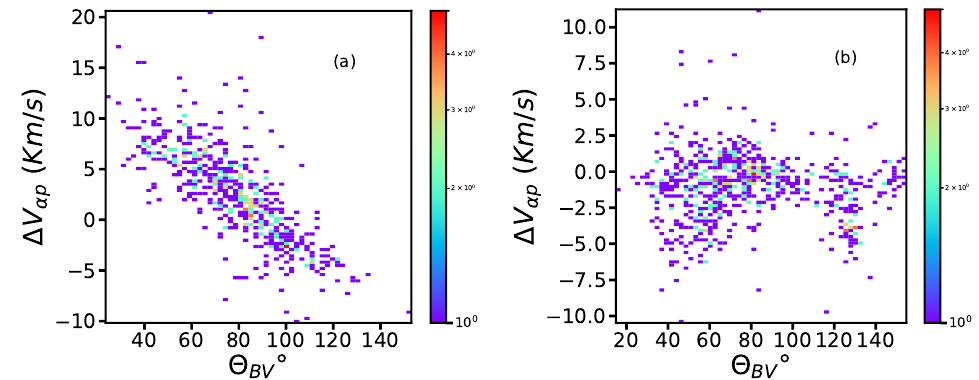
Figure 5. 2D histogram plot of alpha proton drift speed as a function of θ BV of the slow wind intervals observed by WIND at 1 au for the slow Alfvénic wind interval of 19 December 2000 ( a ) and slow non-Alfvénic wind interval on 5 February 2015 ( b ). The color bar represents the number of